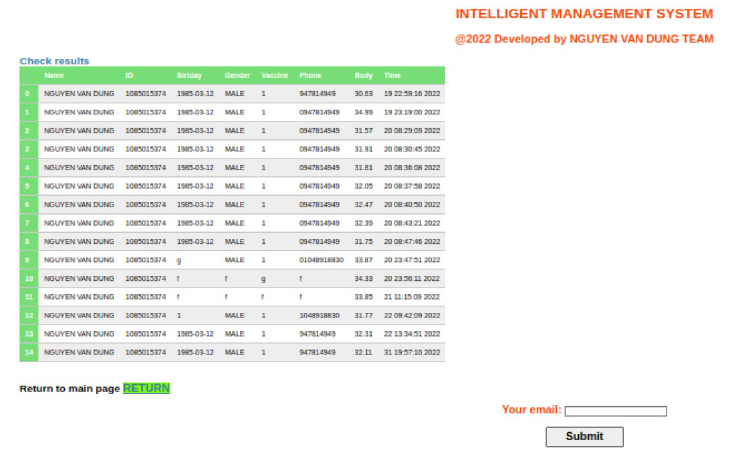
Figure 14. Display of the check page.